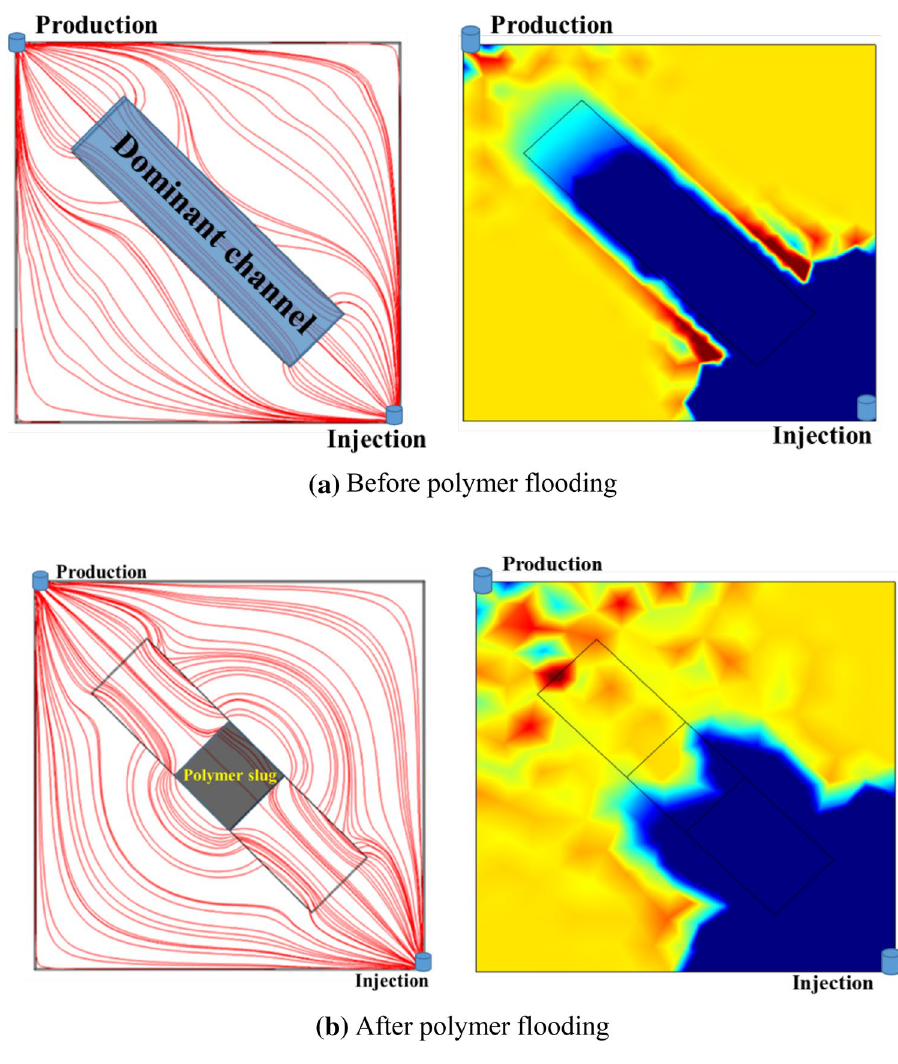
Fig. 4 Streamline and saturation distribution of the injection– production unit before and after polymer flooding